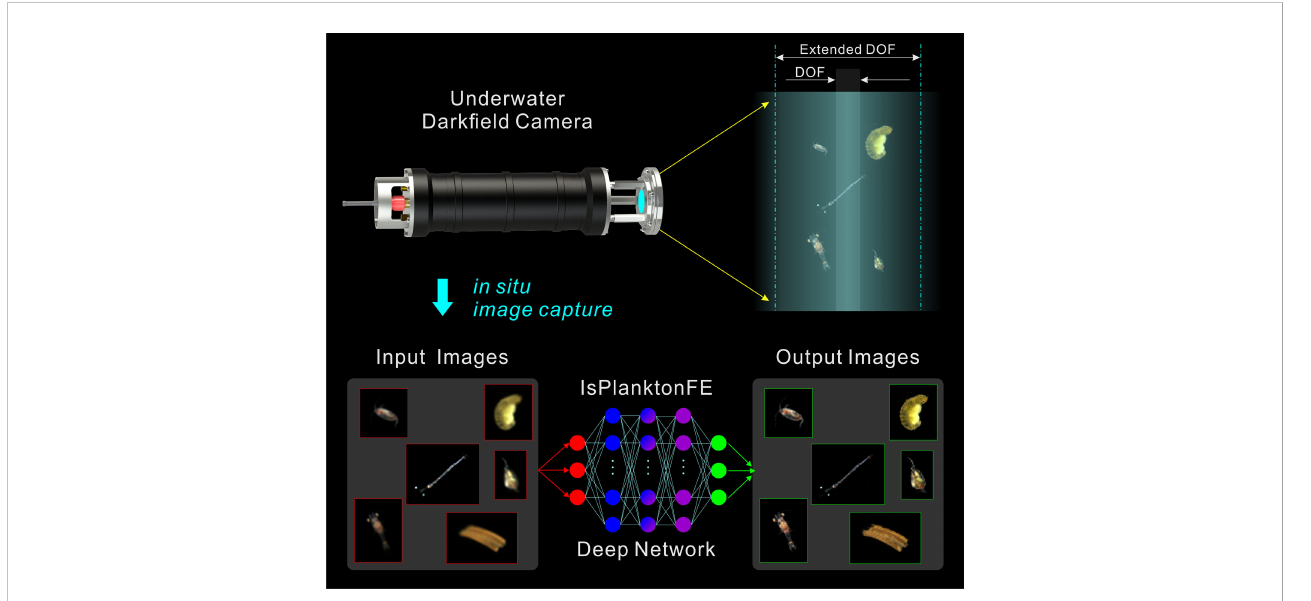
FIGURE 1 Concept of a deep learning-based focus-extension for in situ dark fi eld imaging of marine